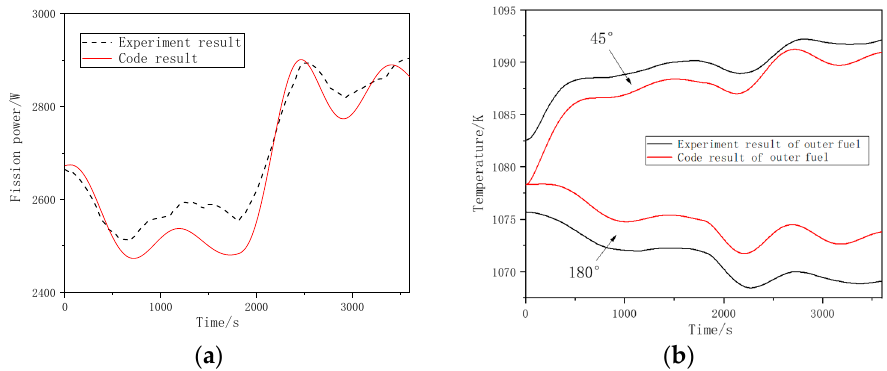
Figure 15. Core power and temperature at the heat pipe failure accident: ( a ) core power and ( b ) temperature.